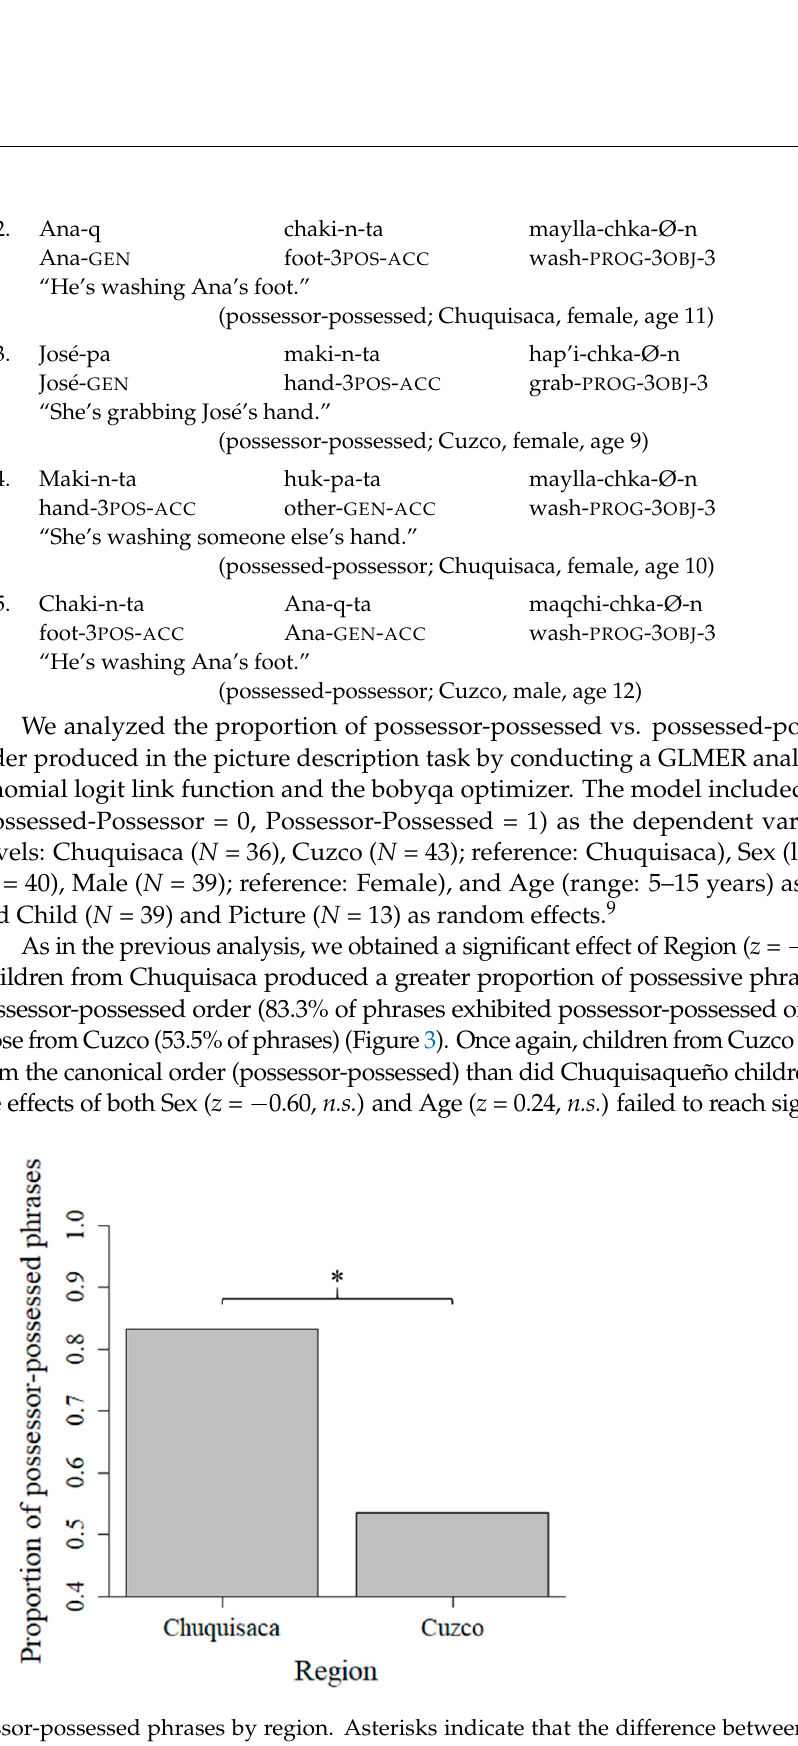
Figure 3. Proportion of possessor-possessed phrases by region. Asterisks indicate that the difference between levels is significant ( p < 0.05).